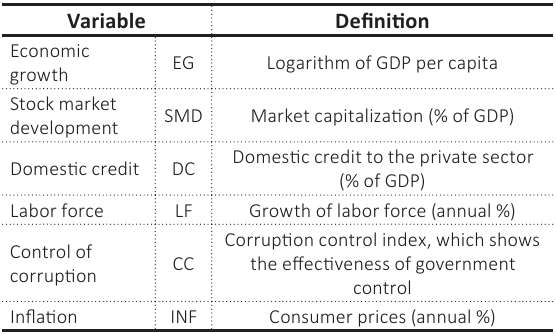
Table 1. Summary of the